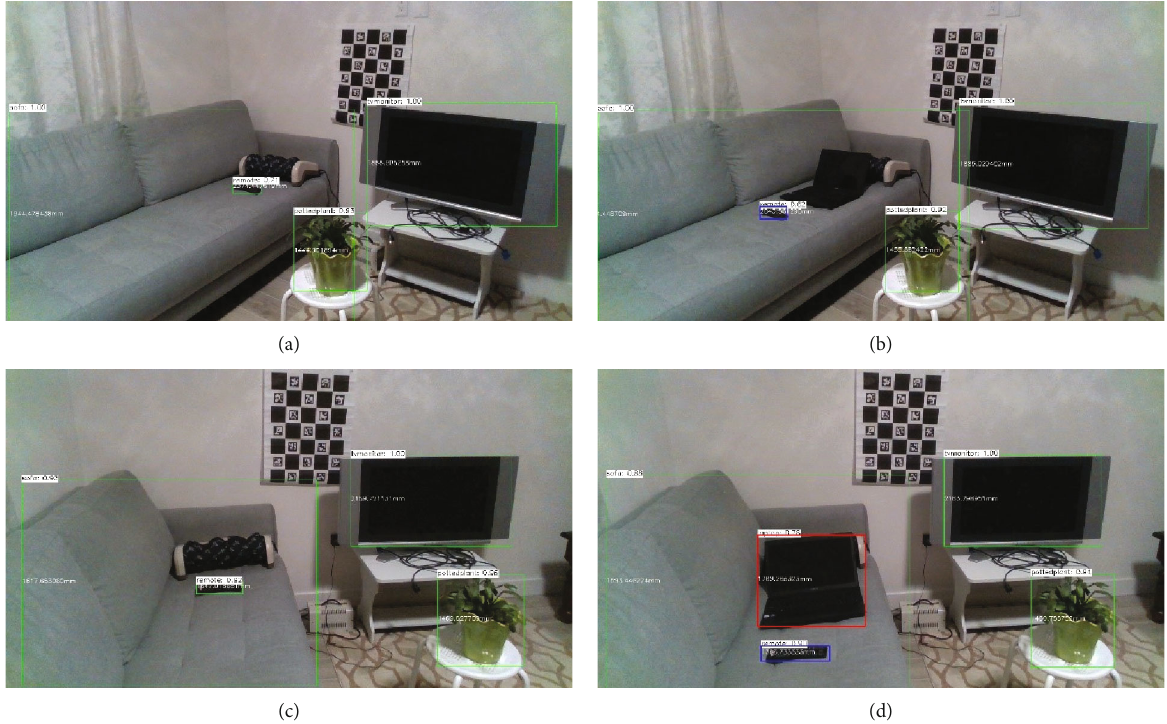
Figure 7: Object detection for before and after the instances when an older adult walks into the monitoring area. Left column (a, c) shows the detected objects at the initial event from left and right sensors, and the right column (b, d) shows the detected objects after the movement event.